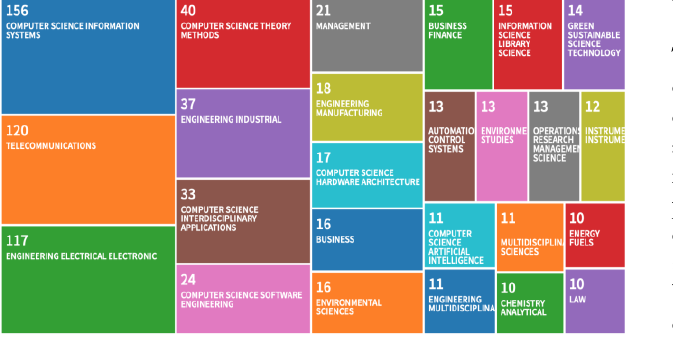
Figure 1: Web of Science Search Results by Discipline.